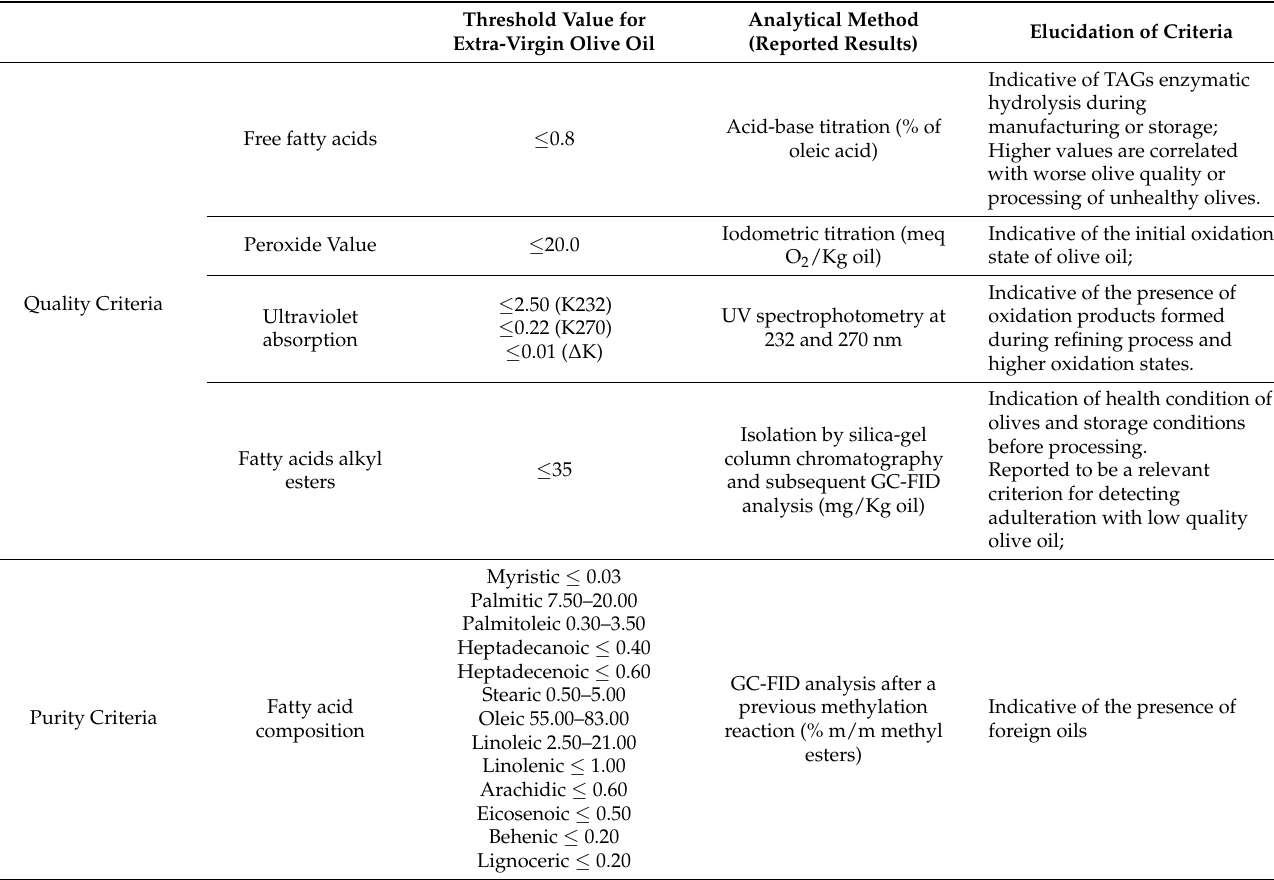
Table 4. Quality and purity criteria established by International Olive Council [92] and European Commission [93].